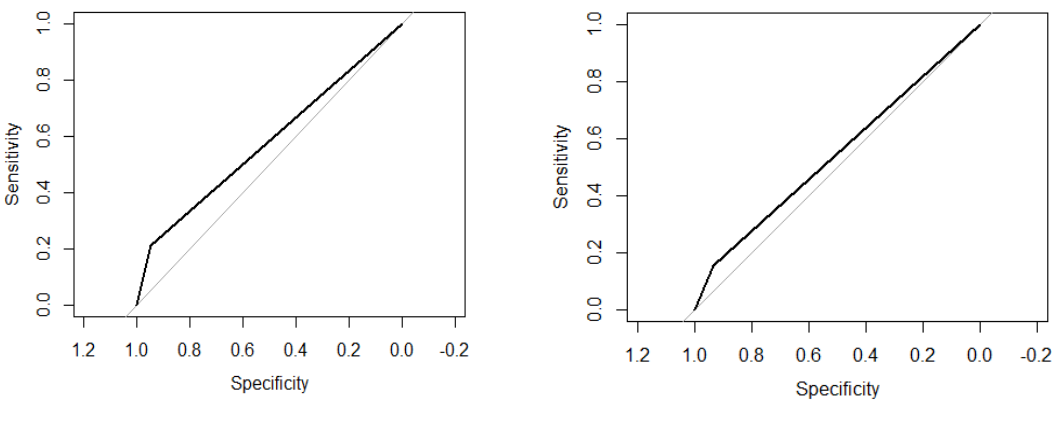
Figure 1. ( a ) Receiver operating characteristic (ROC) curve of dermal electrochemical conductance (DEC) versus electromyography (EMG) as the gold standard in the whole study population. ( b ) ROC curve of DEC versus monofilament (MFT) as the gold standard in the whole study population. AUC: Area under the ROC Curve.